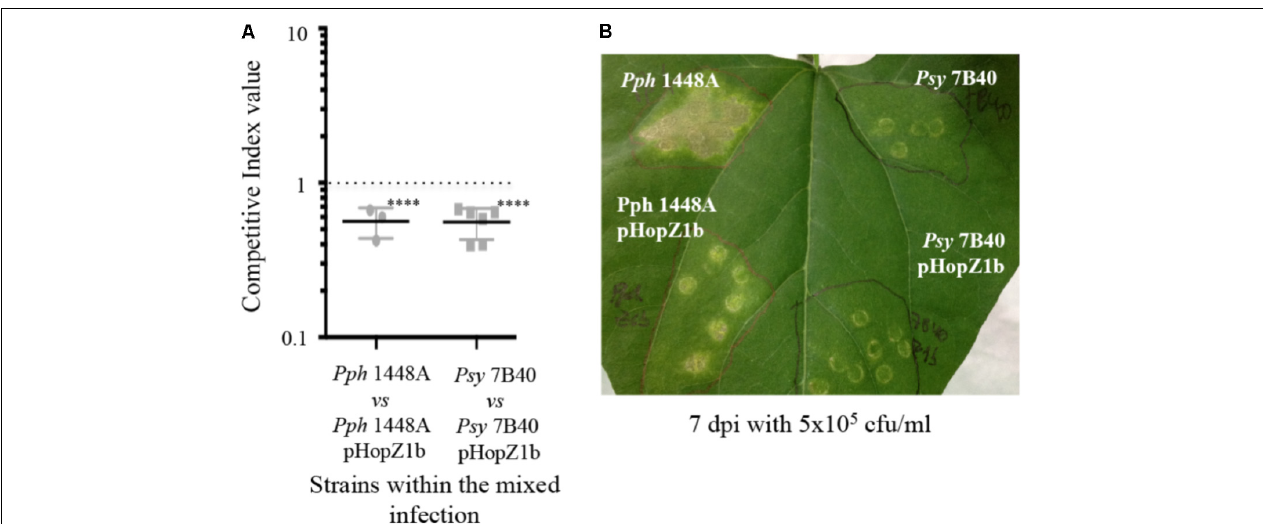
FIGURE 3 | HopZ1b triggers immunity in bean when delivered by either Pph 1448A or Psy 7B40. (A) Competitive indices (CIs) measuring bacterial proliferation in bean of Pph 1448A or Psy 7B40-carrying pHopZ1b (pJRU6, Supplementary Table S2 ), in relation to proliferation of the corresponding strain without the plasmid. CIs are calculated as the output ratio between the strain expressing the effector and the corresponding wild type or mutant strain, divided by their input ratio. Each CI mean represents at least the means of three independent experiments with three biological replicates each. Individual values are shown for each CI. Error bars represent the standard error. Mean values marked with asterisk(s) were found significantly different from 1.00 or from each other as established by Student’s t -test ( ∗∗∗∗ P < 0.001; ns not significant). (B) Disease symptoms to hand-infiltration of bean leaves with bacterial suspensions containing 5 × 10 5 cfu/ml of Pph 1448A or Psy 7B40-carrying or not carrying pHopZ1b (pJRU6). Photographs were taken 7 days post-inoculation. Images are representative of at least three inoculated leaves per strain and experiment. The experiment was repeated at least twice with similar